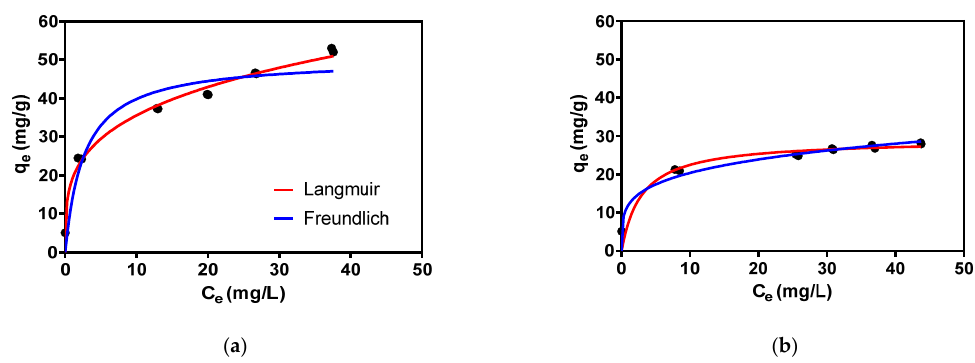
Figure 4. Arsenic isotherm materials. ( a ) MIRESORB TM ; ( b ) GFH. The initial As(V) concentration was 50 mg/L, the adsorbent dose was 0.01–10 g/L, the pH was 6.6, and the contact time was 48 h. Table 4. Isotherm parameters for As(V) adsorption to MIRESORB TM and GFH materials.